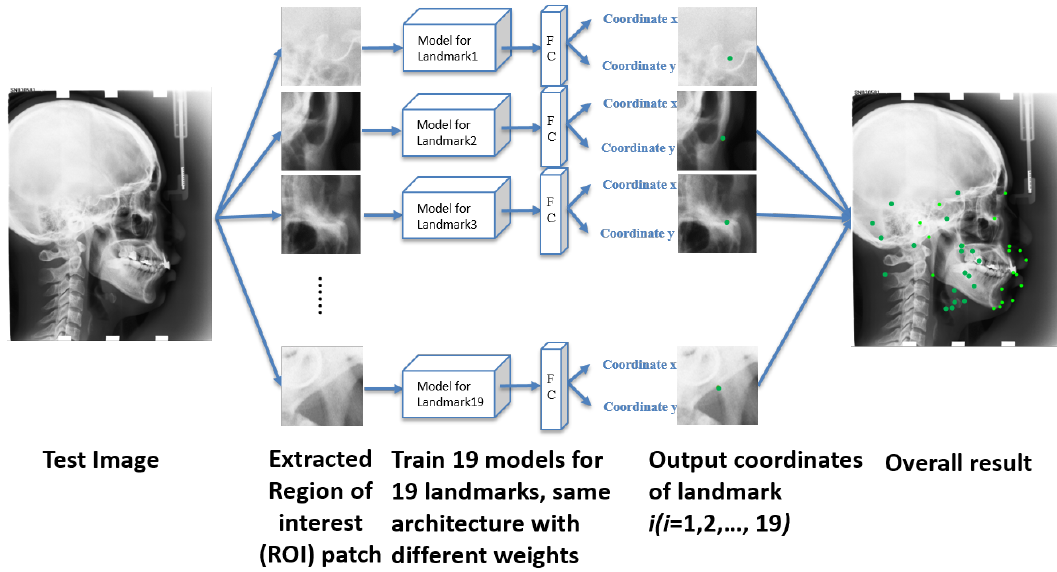
Figure 2. We train 19 networks with same architecture but with different